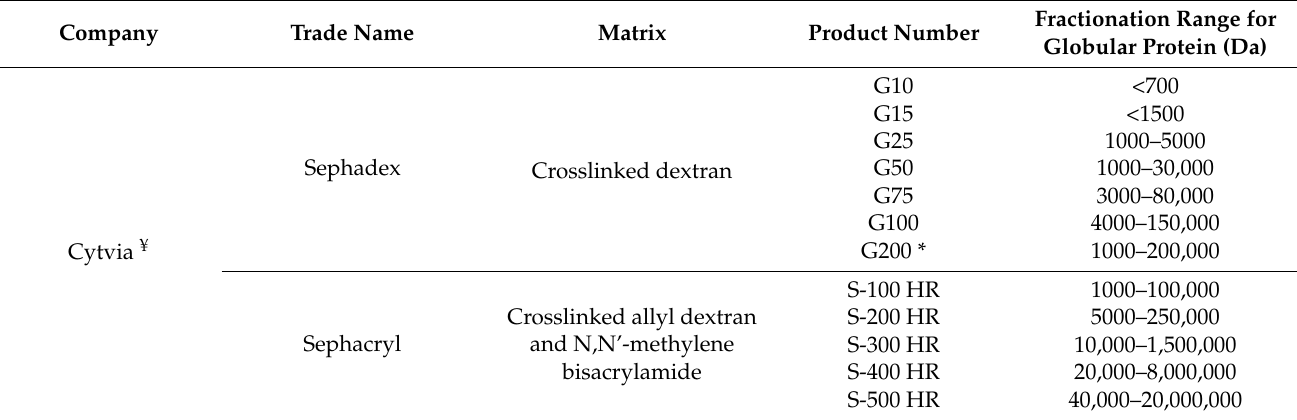
Table 1. Non-exhaustive list of commercially available SEC